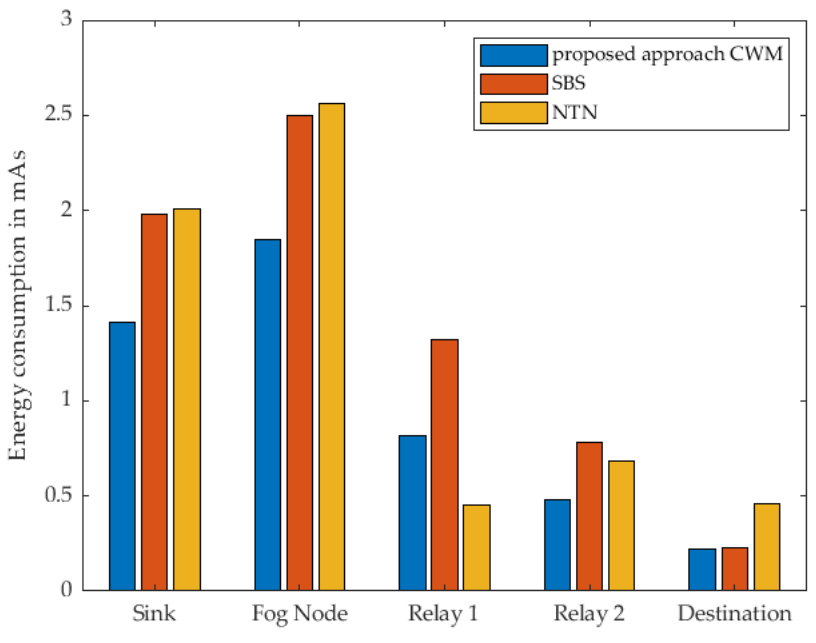
Figure 13. Measured energy consumption of every single node using 2 Relays.